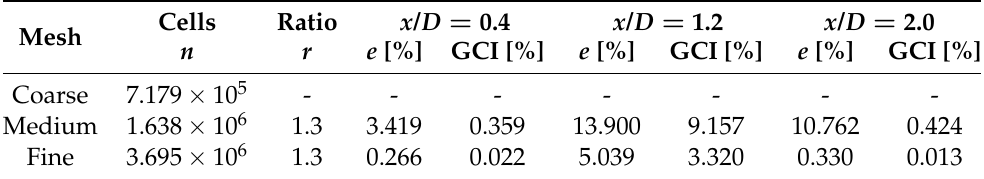
Table 1. Grid details and GCI for the conventional approach. Assessment is made at three locations downstream of the jet centerline for the passive scalar c